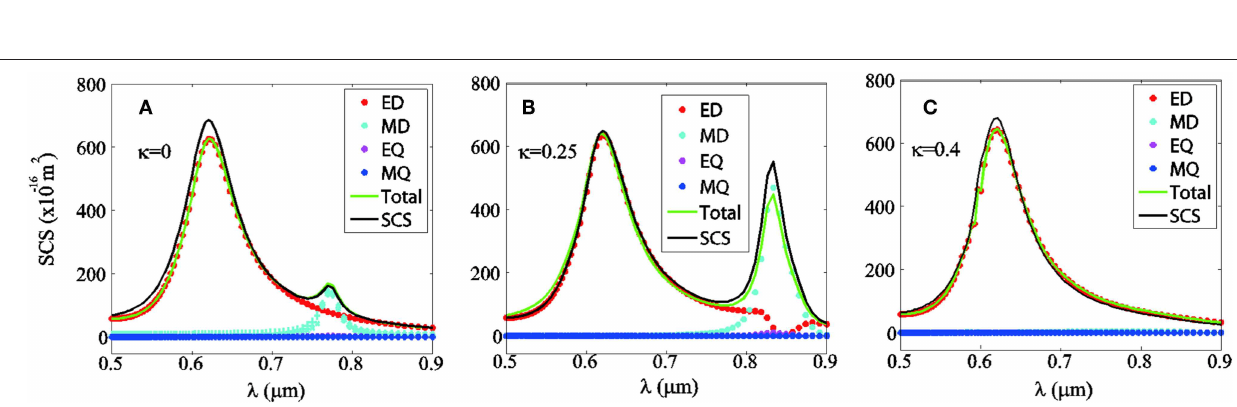
FIGURE 1 | Optical response of the plasmonic antenna. (A) Schematic of the five layered plasmonic nanoantenna, composed of planar metallic strips separated by loss ( n + i κ ) and gain ( n − i κ ) materials. (B) Extinction cross section as a function of κ and the wavelength λ . (C) Extinction (blue curves), scattering (red curves), and absorption (black curves) cross-sections for the same antenna of panel by calculated for three different κ : κ = 0 (top), κ = 0.25 (middle), and κ = 0.4 (bottom).